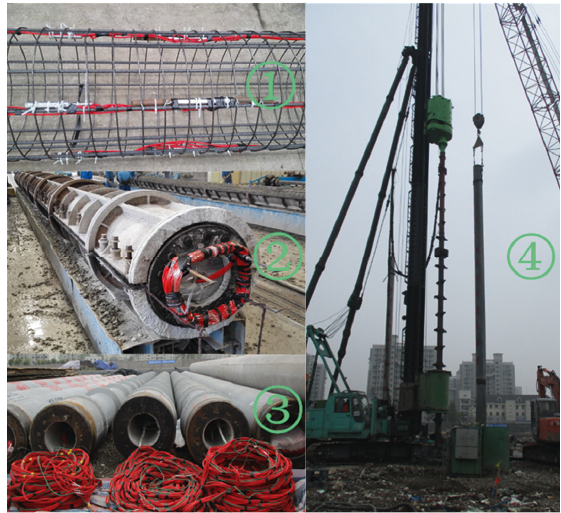
Figure 2: Manufacturing